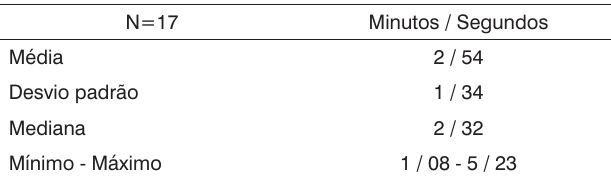
Tabela 3. Resultados encontrados no Teste da Sacarina (TS).